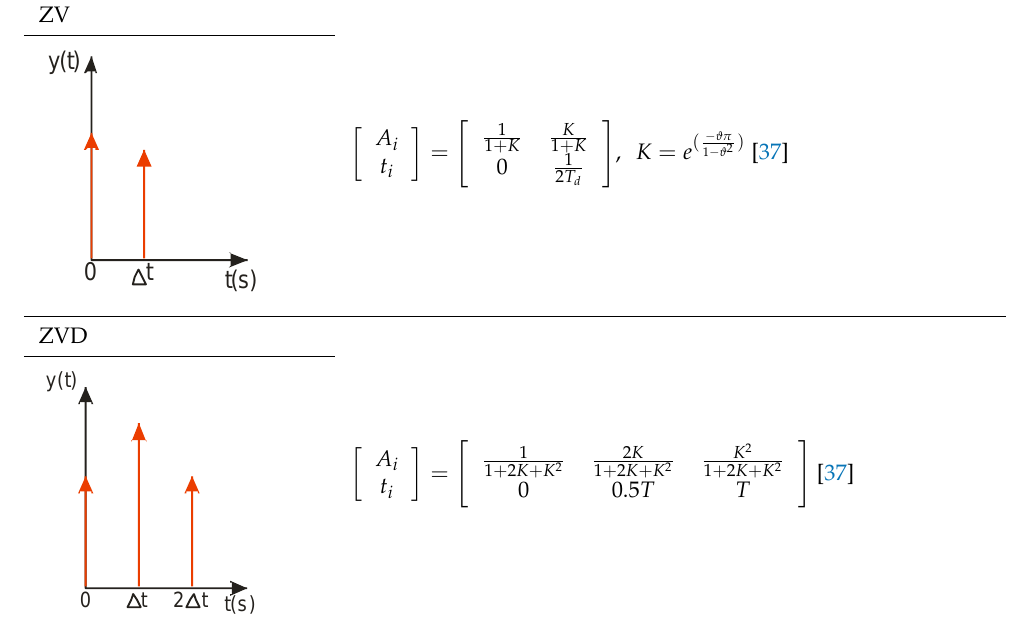
Table 1. The form of pulses for individual ISC algorithms.